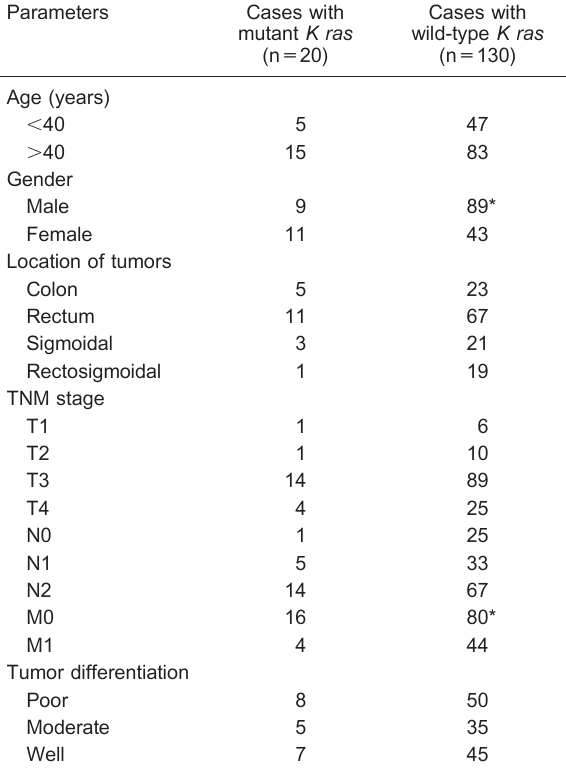
Table 1. Correlation of different parameters to K ras